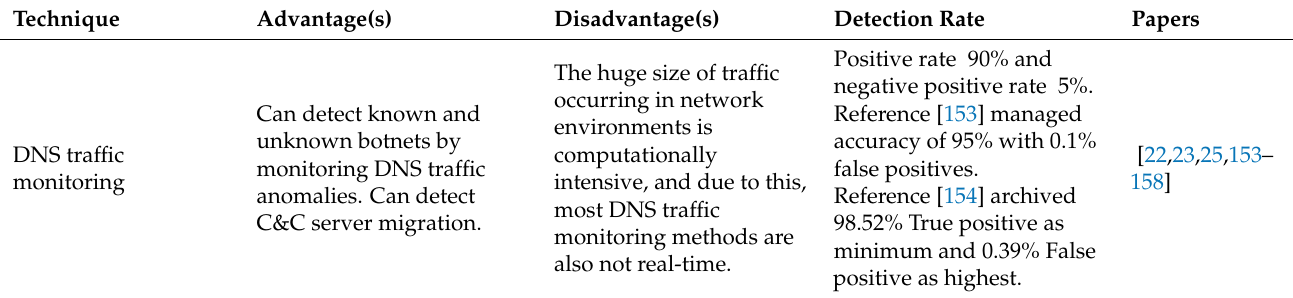
Table 6. Papers describing detection of botnets using DNS-based techniques. Each column describes the overall technique, known advantages, disadvantages, detection rate and related papers, respectively. Technique Detection Rate